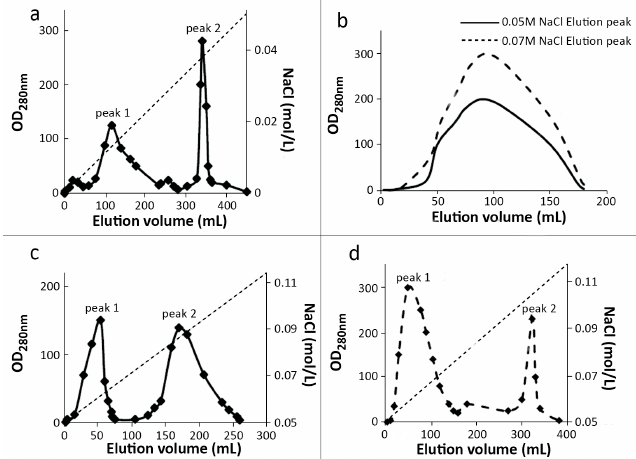
Figure 1. Elution profile of mono-PEGylated RIPs on Macro-Cap SP and SP-Sepharose FF column. ( a ) Chromatography of α -MMC and mono-PEGylated α -MMC fractions on Macro-Cap SP column. Peak 1 was 10 kDa-mono-PEGylated α -MMC and peak 2 was unmodified α -MMC; ( b ) chromatography of α -MMC and mono-PEGylated α -MMC fractions on SP-Sepharose FF column. 0.05 M NaCl elution peak was 10 kDa-mono-PEGylated α -MMC and 0.07 M NaCl elution peak was unmodified α -MMC; and ( c , d ) were the chromatography profiles of MAP30 and mono-PEGylated MAP30 fractions on the Macro-Cap SP and the SP-Sepharose FF column. Peak 1 were 10 kDa mono-PEGylated MAP30 and peak 2 were unmodified MAP30. The unconjugated mPEG-SC was washed away in the first step when adding samples to the Macro-Cap SP column or the SP-Sepharose FF column.